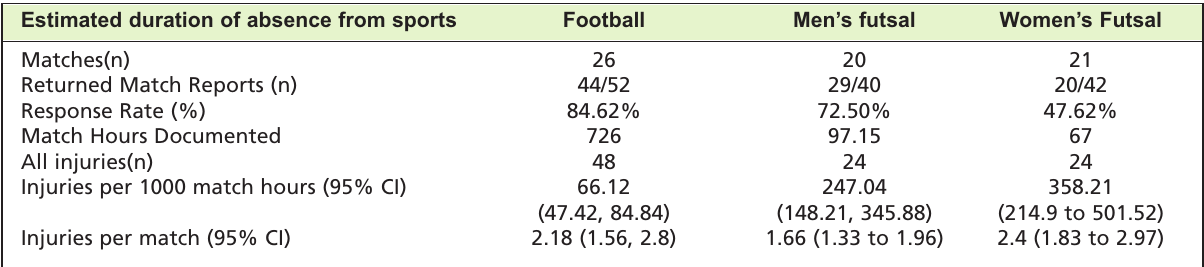
Number of matches, response rate, severity and incidence of injury in football and futsal. Table I: